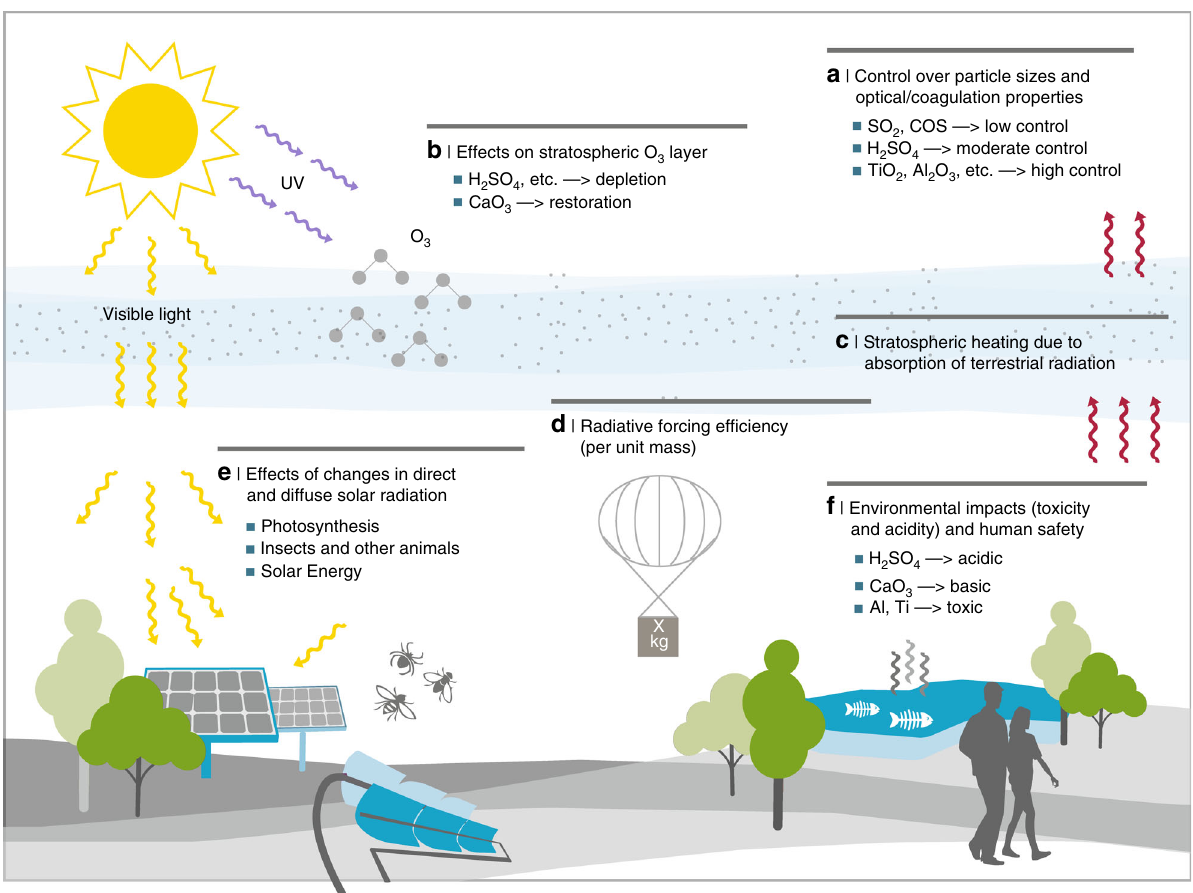
Fig. 4 Key scienti fi c and technical considerations and challenges for stratospheric aerosol injection (SAI). A wide range of scienti fi c and technical factors would need to be considered in choosing which particle composition or combination of particle types to employ in possible implementation of SAI: a A high degree of control would be desired over the resulting aerosol particle size distribution, which in fl uences the aerosol layer optical properties (for both solar and terrestrial radiation), the residence time, and the dispersion and transport of the aerosol layer. Such control would be more straightforward